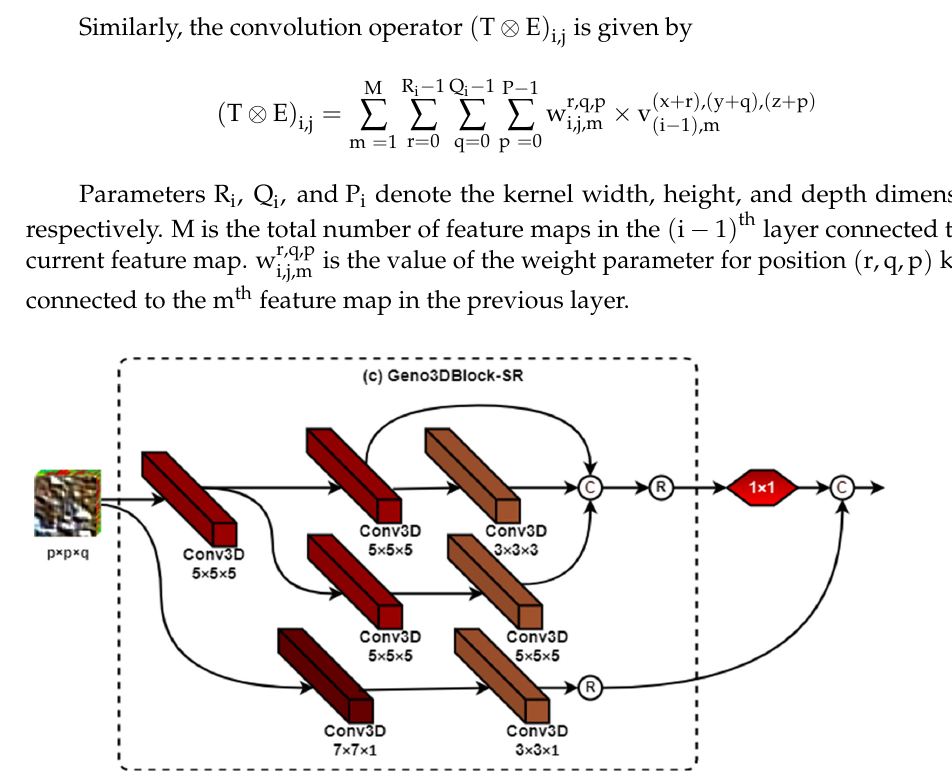
Figure 7. Framework of Geno3Dblock-SSR. Similarly, the convolution operator (T⨂E) (cid:2919),(cid:2920) is given by (T⨂E) (cid:2919),(cid:2920) = (cid:3533) (cid:3533) (cid:3533) (cid:3533) w (cid:2919),(cid:2920),(cid:2923)(cid:2928),(cid:2927),(cid:2926)(cid:2900)(cid:2879)(cid:2869) (cid:2926) (cid:2880) (cid:2868)(cid:2901) (cid:3167) (cid:2879)(cid:2869) (cid:2927)(cid:2880) (cid:2868)(cid:2902) (cid:3167) (cid:2879)(cid:2869) (cid:2928)(cid:2880) (cid:2868)